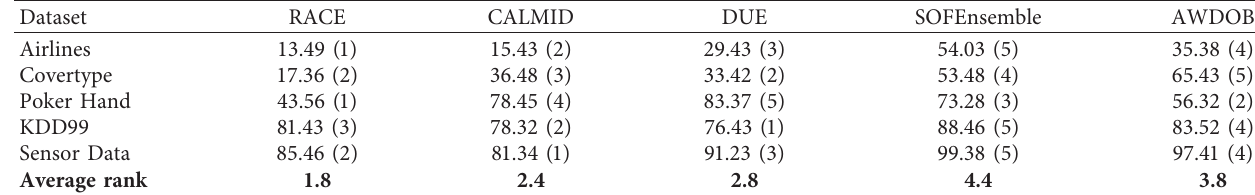
Table 6: CPU processing time for each algorithm on real-world